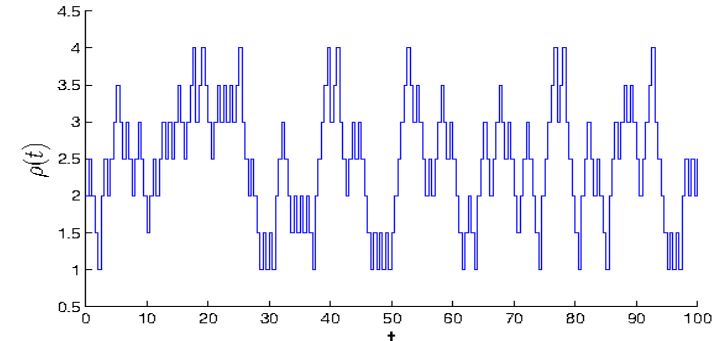
Figure 4. The graph of the piecewise constant unpredictable function ρ ( t ) = X n ξ ( t − nh ) , t ∈ [ hn , h ( n + 1 )) , n = 0,1,2, . . . The vertical lines are drawn for better visibility.